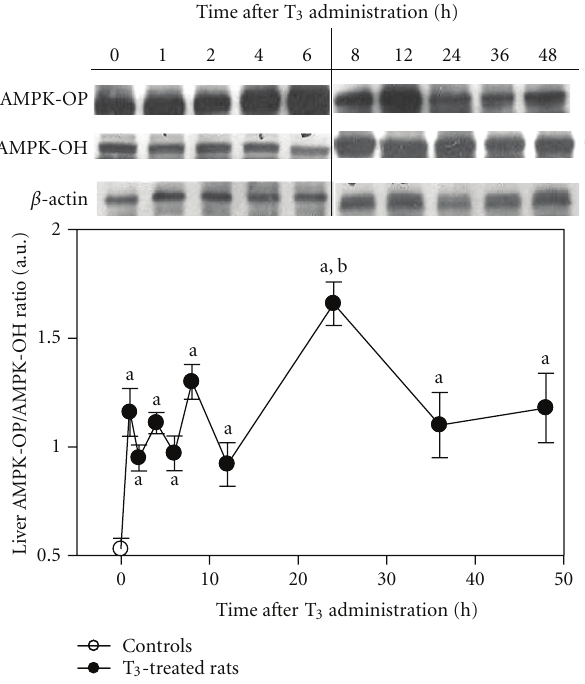
Figure 4: E ff ect of L-3,3 (cid:2) ,5-triiodothyronine (T 3 ) administration on rat liver AMP-activated protein kinase (AMPK). Male Sprague- Dawley rats (Animal facility of the Institute of Biomedical Sciences, Faculty of Medicine, University of Chile) weighing 180–200